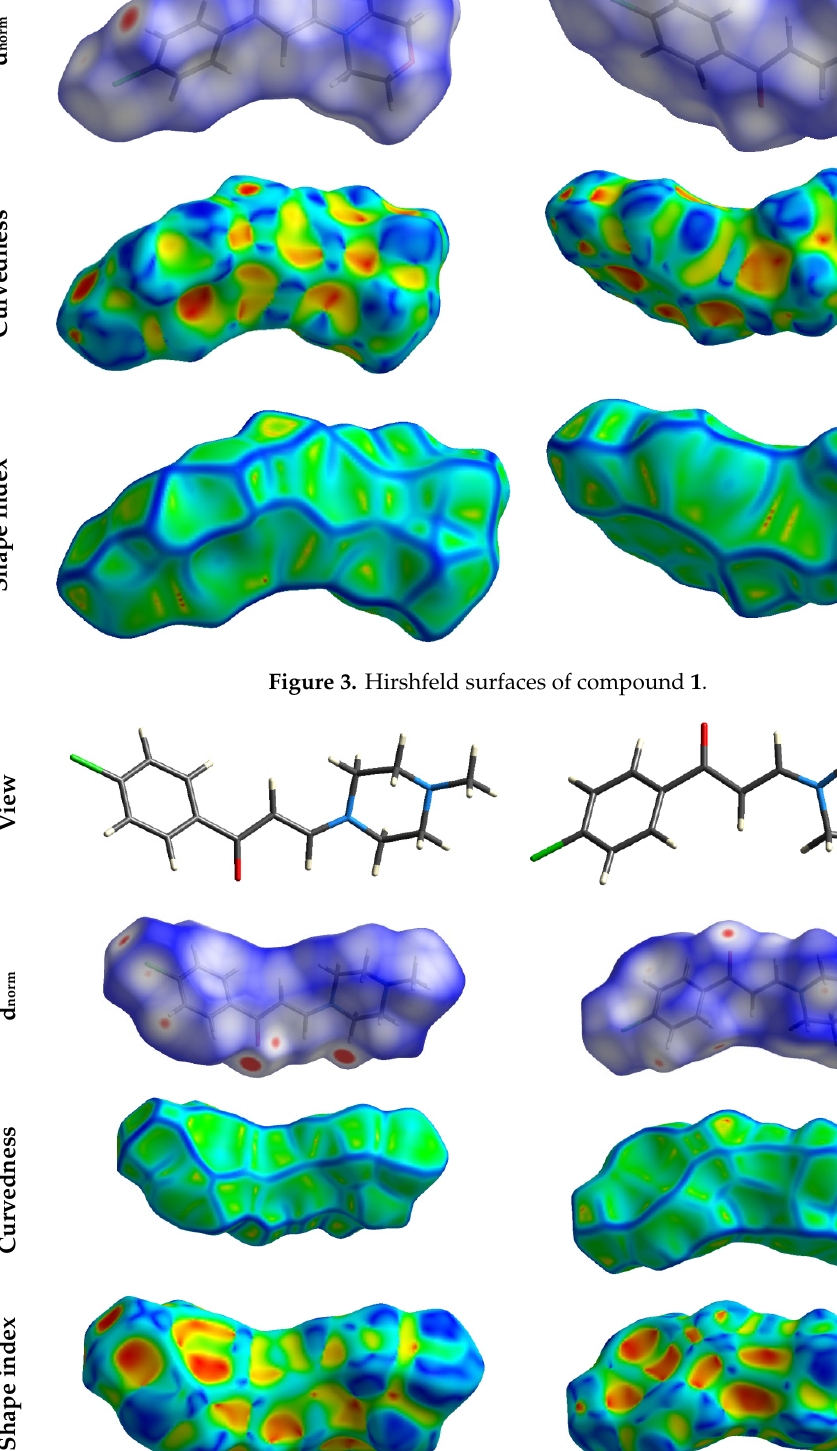
Figure 4. Hirshfeld surfaces of compound 2 .